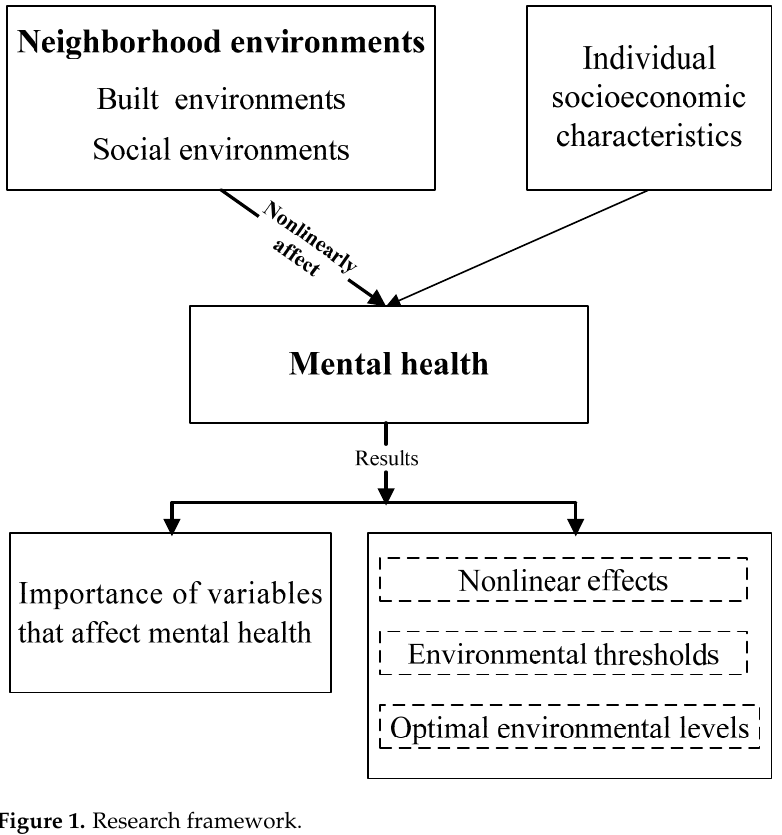
Figure 1. Research